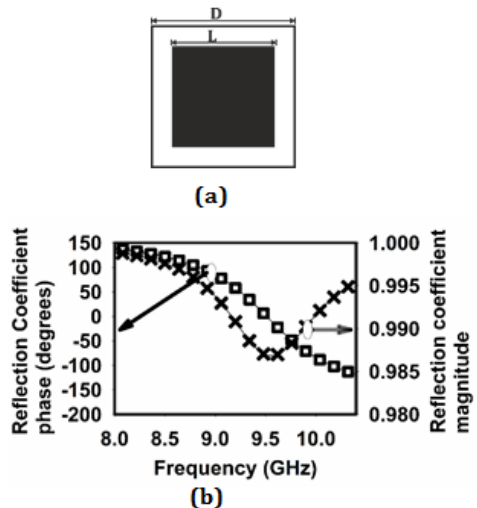
Figure.2. AMC ground plane (a) unit cell (D = 11.5